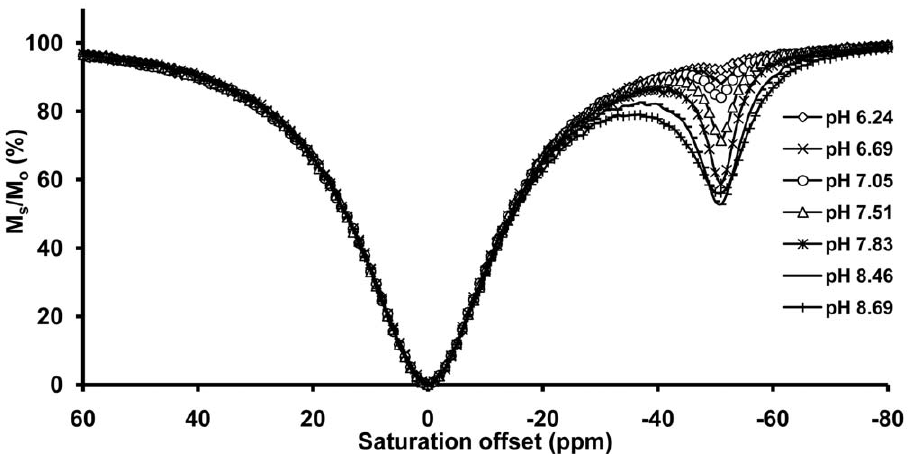
Figure 3. CEST spectra of TmDOTA-(gly) 4 2 collected at different pH values. Each spectrum was recorded at 9.4 T on 20 mM samples at pH 7.5 and 310 K. (B 1 =21.2 m T, presaturation time=2 s).